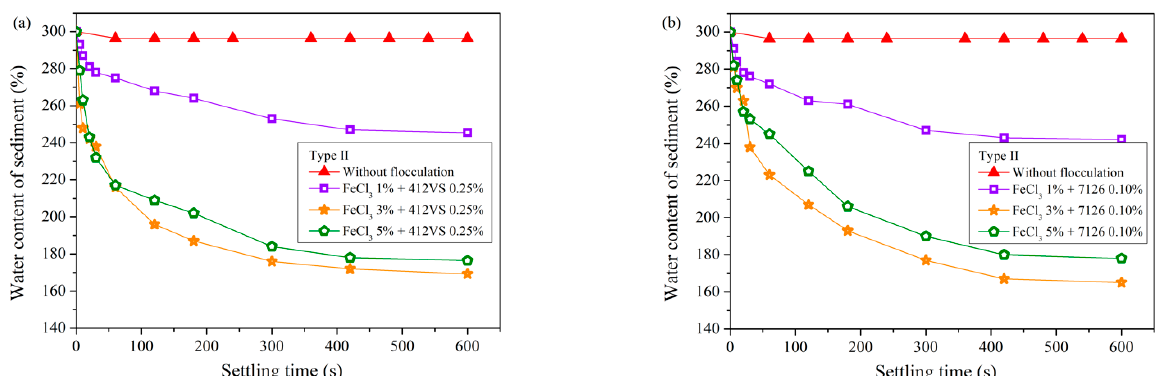
Figure 7. Sedimentation results of slurry (Type Ⅱ ) after compound pretreatment. ( a ) FeCl 3 + 412VS. ( b ) FeCl 3 + 7126.